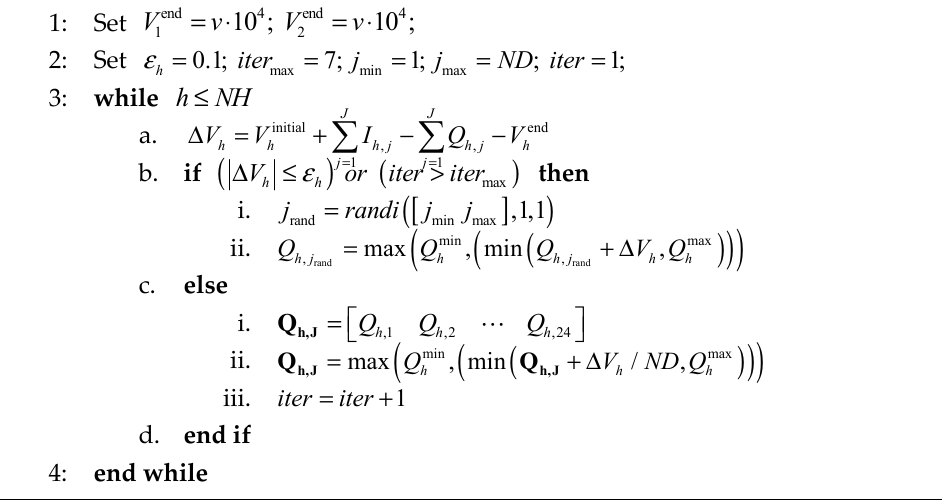
Algorithm 1: New constraints handling for reservoir storage volume (initial and final reservoir storage)